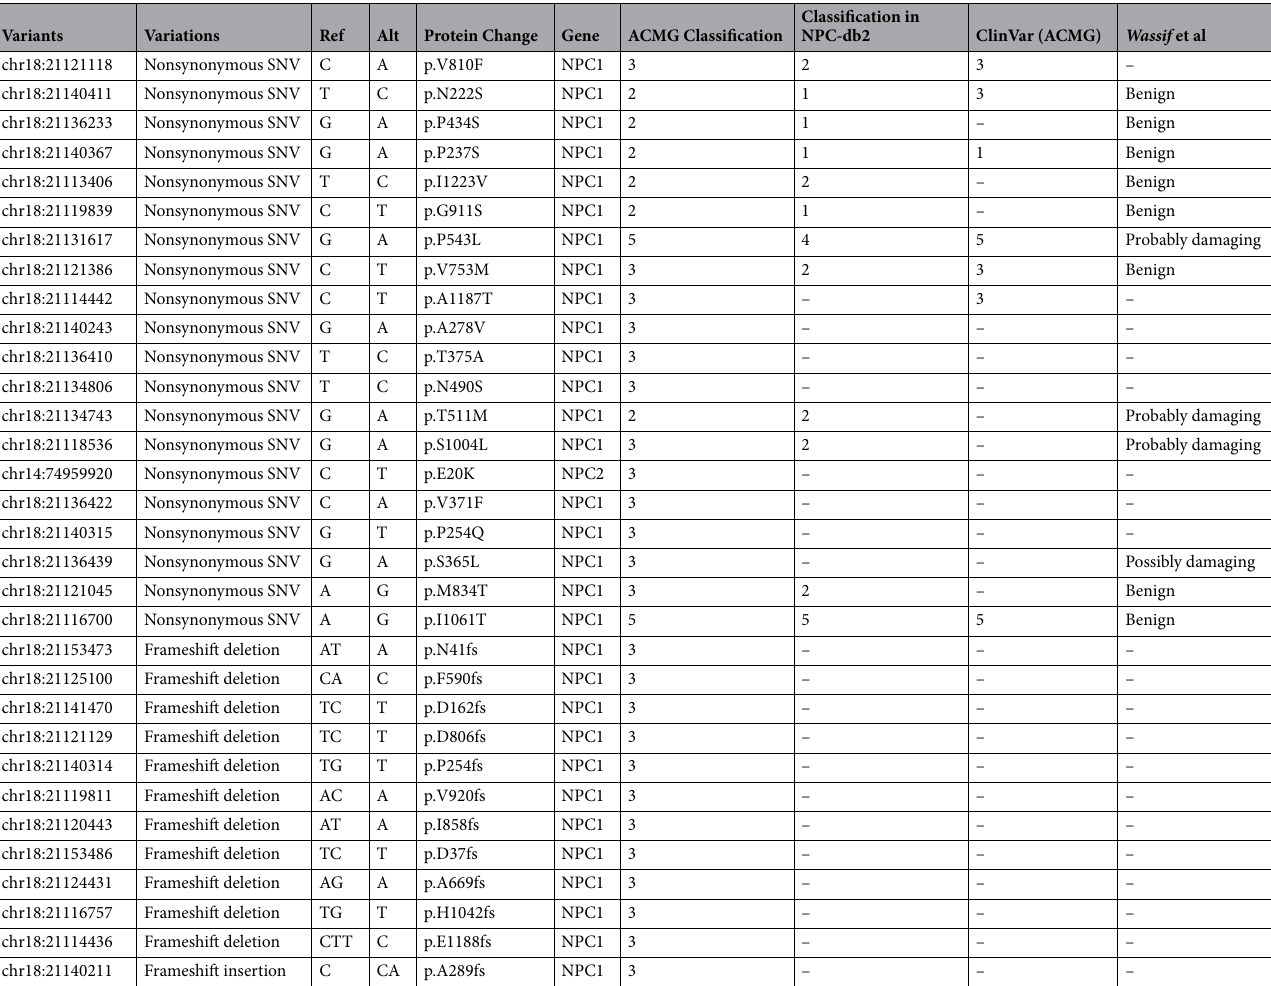
Table 2. Rare variants in CARTaGENE sample, RNA-seq. a Classification 1: Benign 2: Likely benign 3: Uncertain significance 4: Likely pathogenic 5: